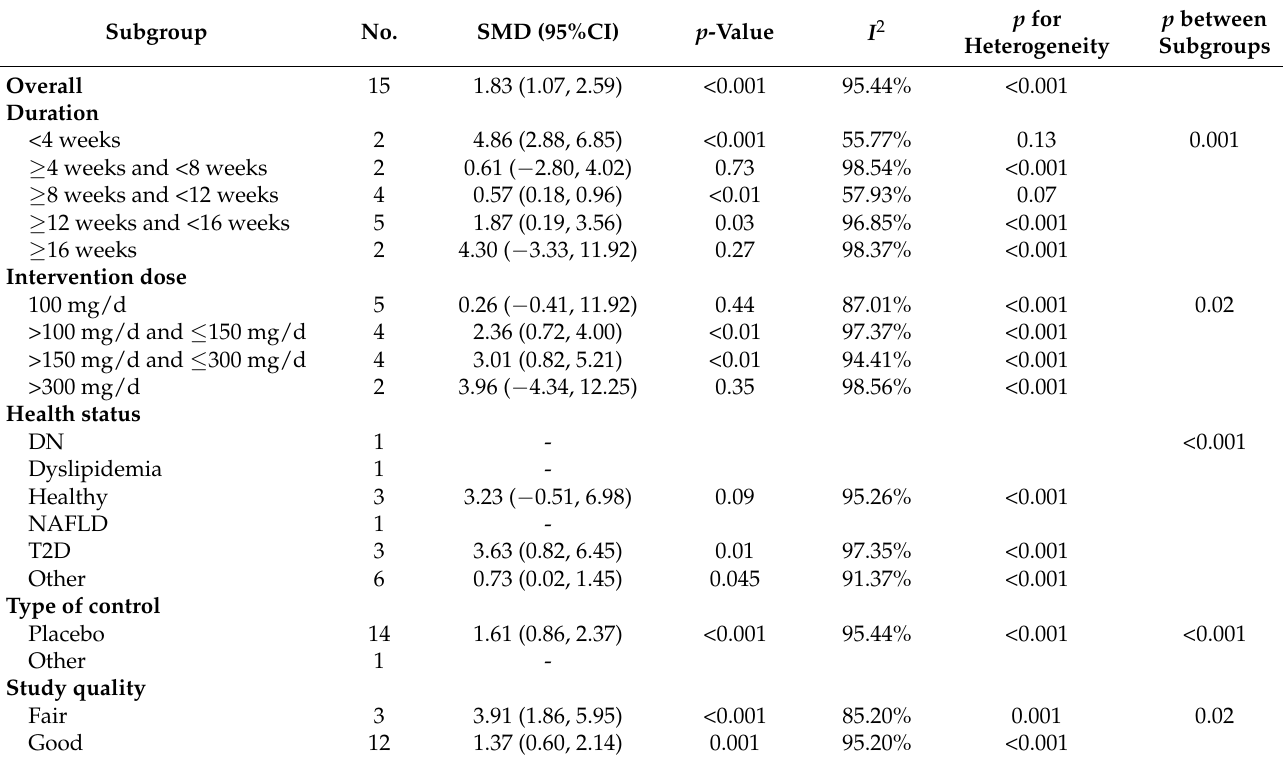
Table 2. Subgroup analyses of CoQ10 supplementation on